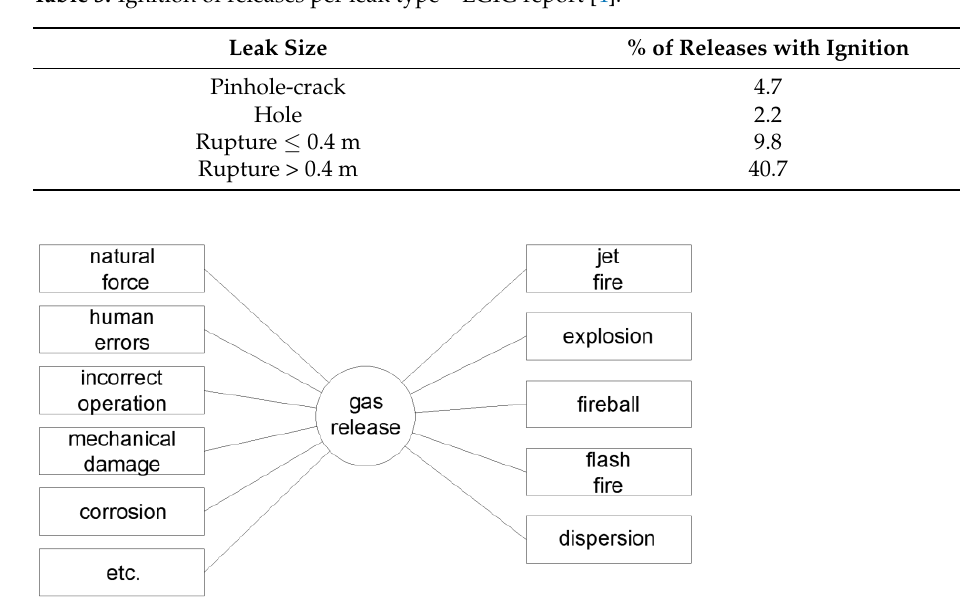
Figure 7. Major events from a natural gas pipeline [24,25]. Table 3. Ignition of releases per leak type—EGIG report